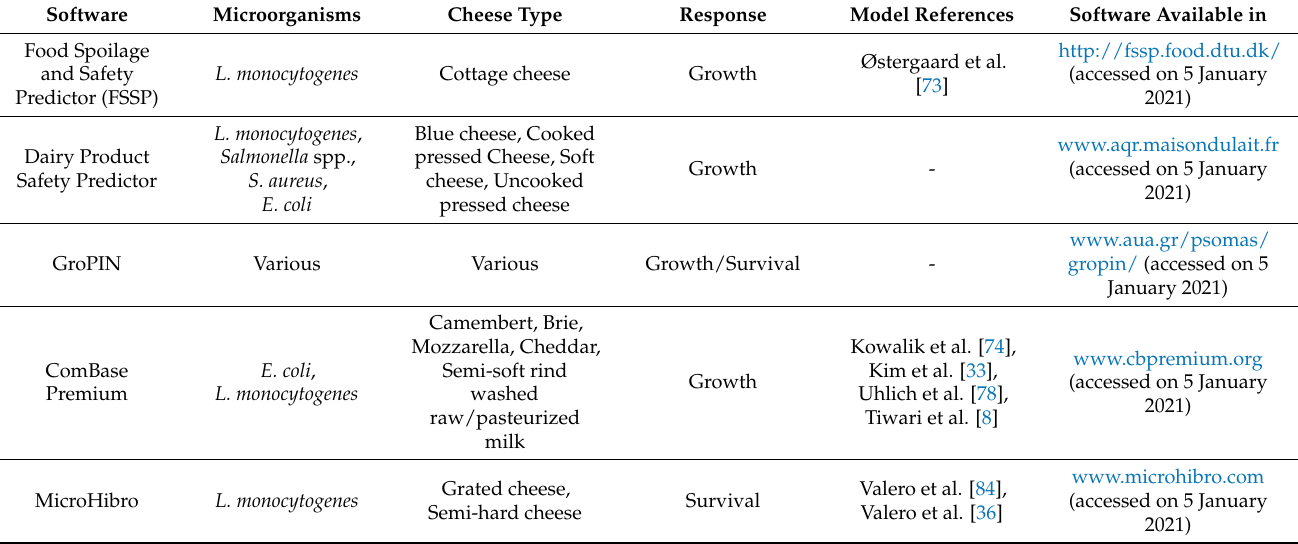
Table 3. Software tools integrating predictive models developed in